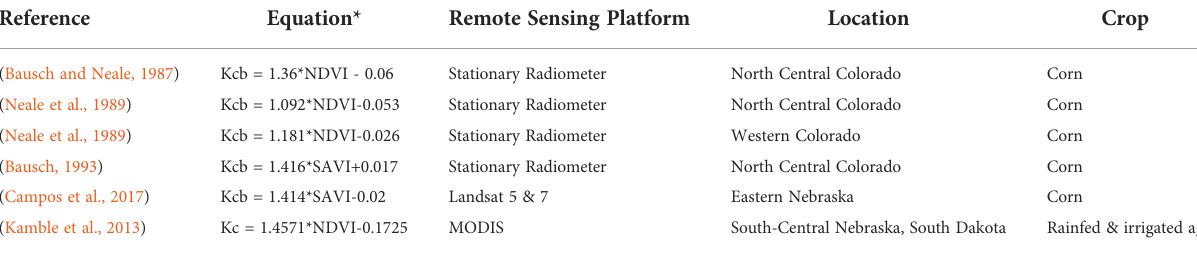
TABLE 1 Linear models correlating corn evapotranspiration coef fi cients to vegetation indices derived from multispectral re fl